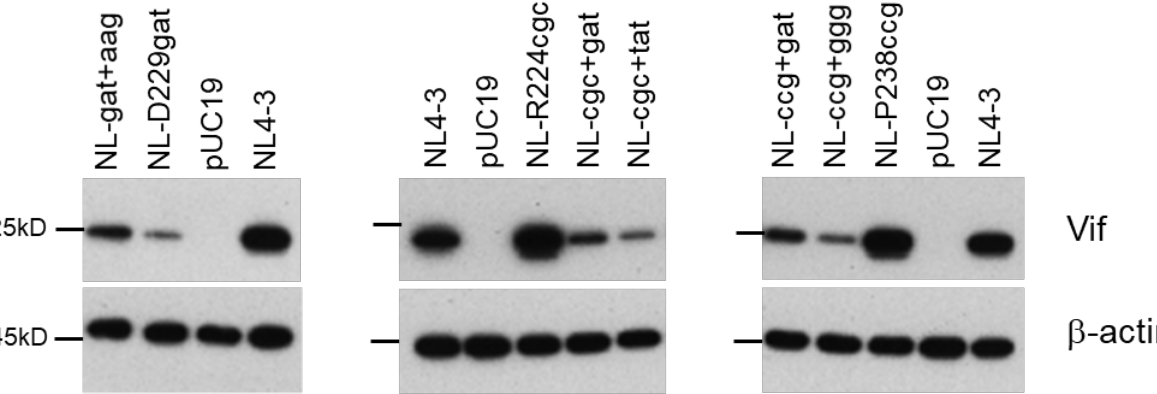
Figure 6. Effects of adaptive mutations within SA1D2prox on the Vif expression level. HEK 293T cells were transfected with the indicated pro-viral clones. On day 1 post-transfection, cell lysates were prepared for Western blotting analysis using anti-Vif and anti- β -actin antibodies. Adaptive mutations that change the Vif expression levels found within the SA1D2prox region of NL-D229gat, NL-R224cgc, and NL-P238ccg are shown in Tables 2–4, respectively. Representative data from two independent experiments are shown. gat, D229gat; aag, R269Kaag; cgc, R224cgc; tat, Y227tat; ccg, P238ccg; ggg, G237ggg.